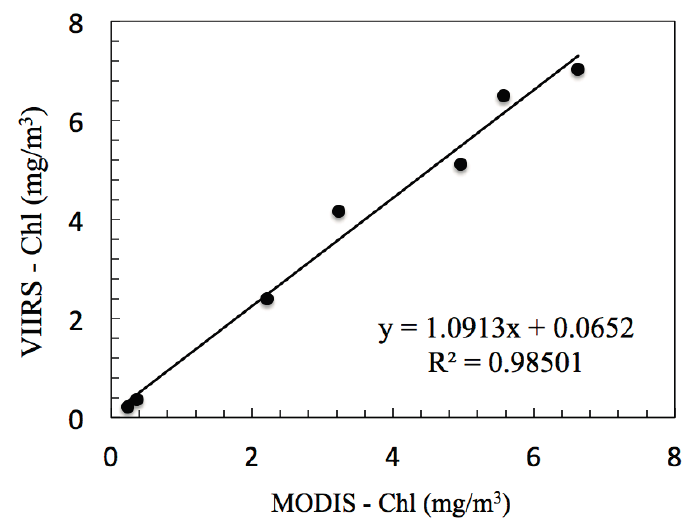
Figure 7. Scatter plot of VIIRS chlorophyll concentration versus MODIS chlorophyll